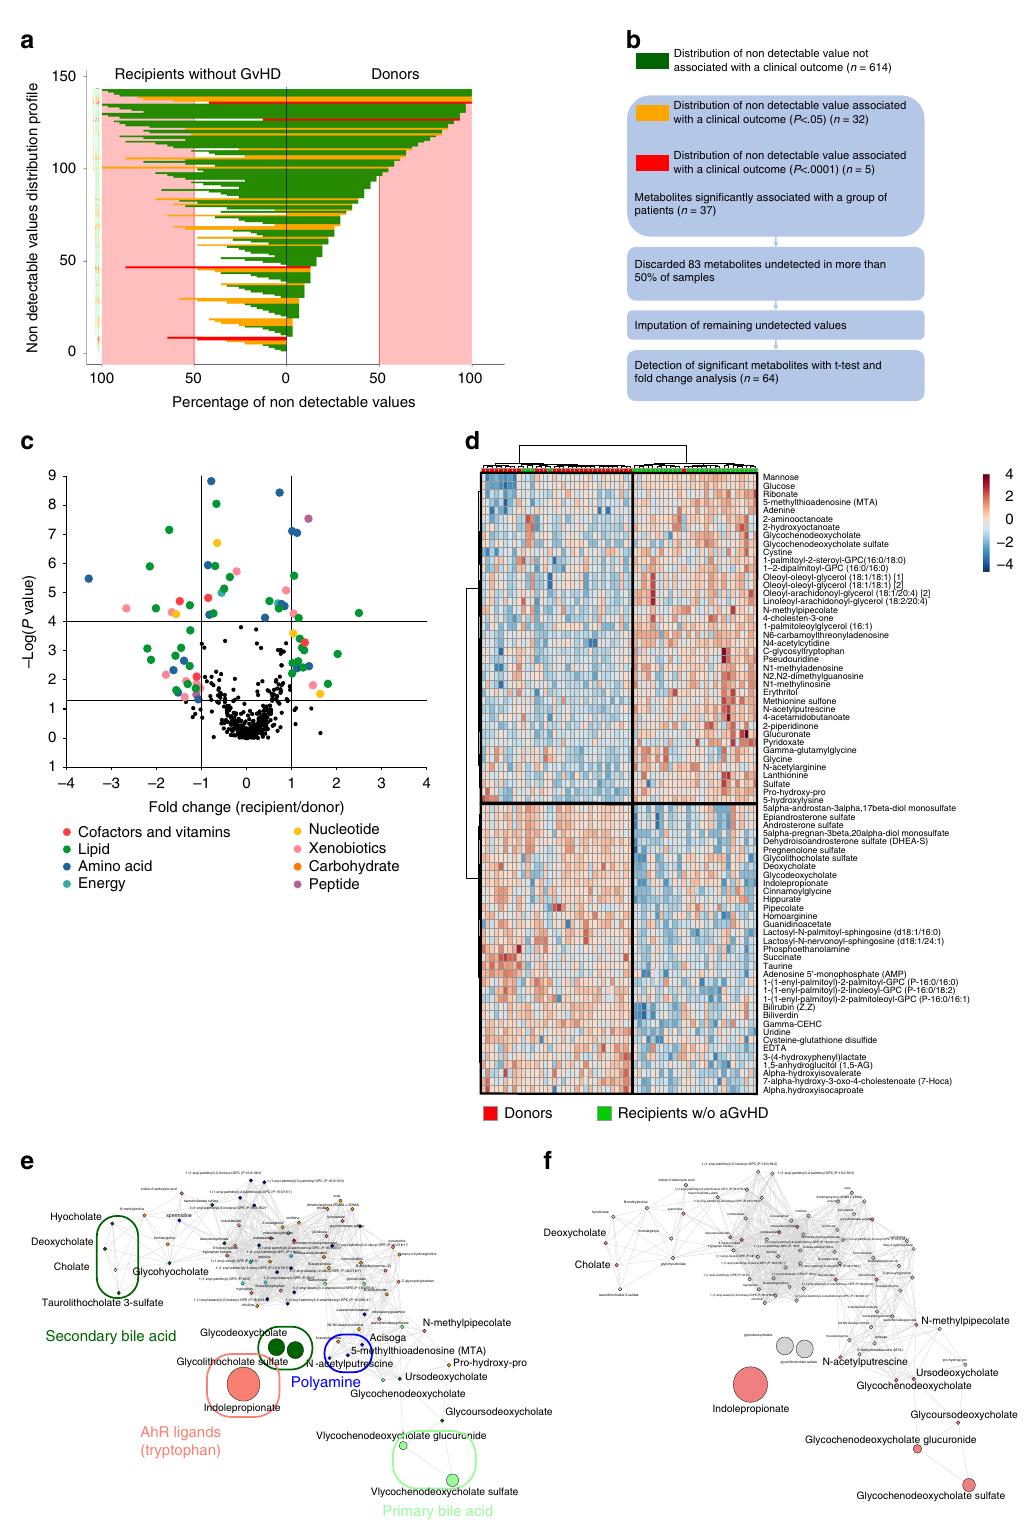
(Fig. 6c, d, Supplementary Data 14) and used to build an over- representation analysis (ORA) of the main pathways that contribute to GvHD (Fig. 6e, f). This approach con fi rmed that most of metabolites identi fi ed in univariate analysis were also selected by sPLS-DA and belong to the previously identi fi ed metabolic path- ways, especially plasmalogens, arginine, and tryptophan